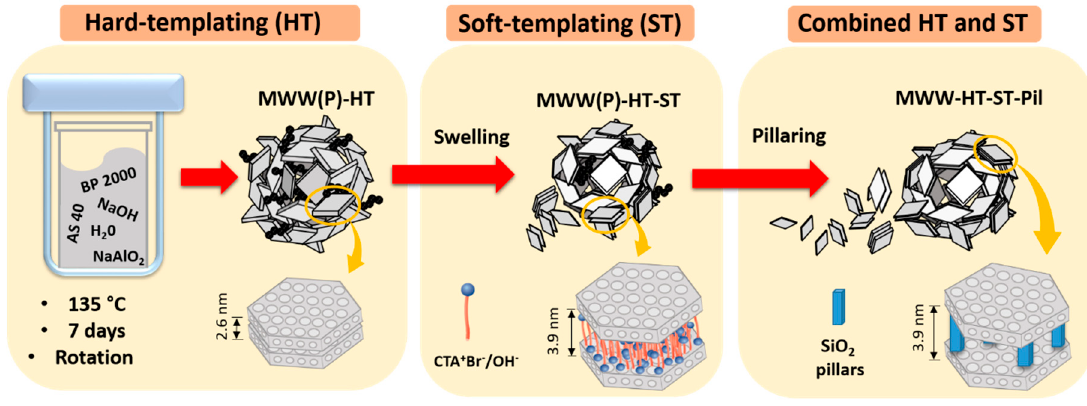
Figure 5. General scheme of the obtained material combining HT and ST approaches.